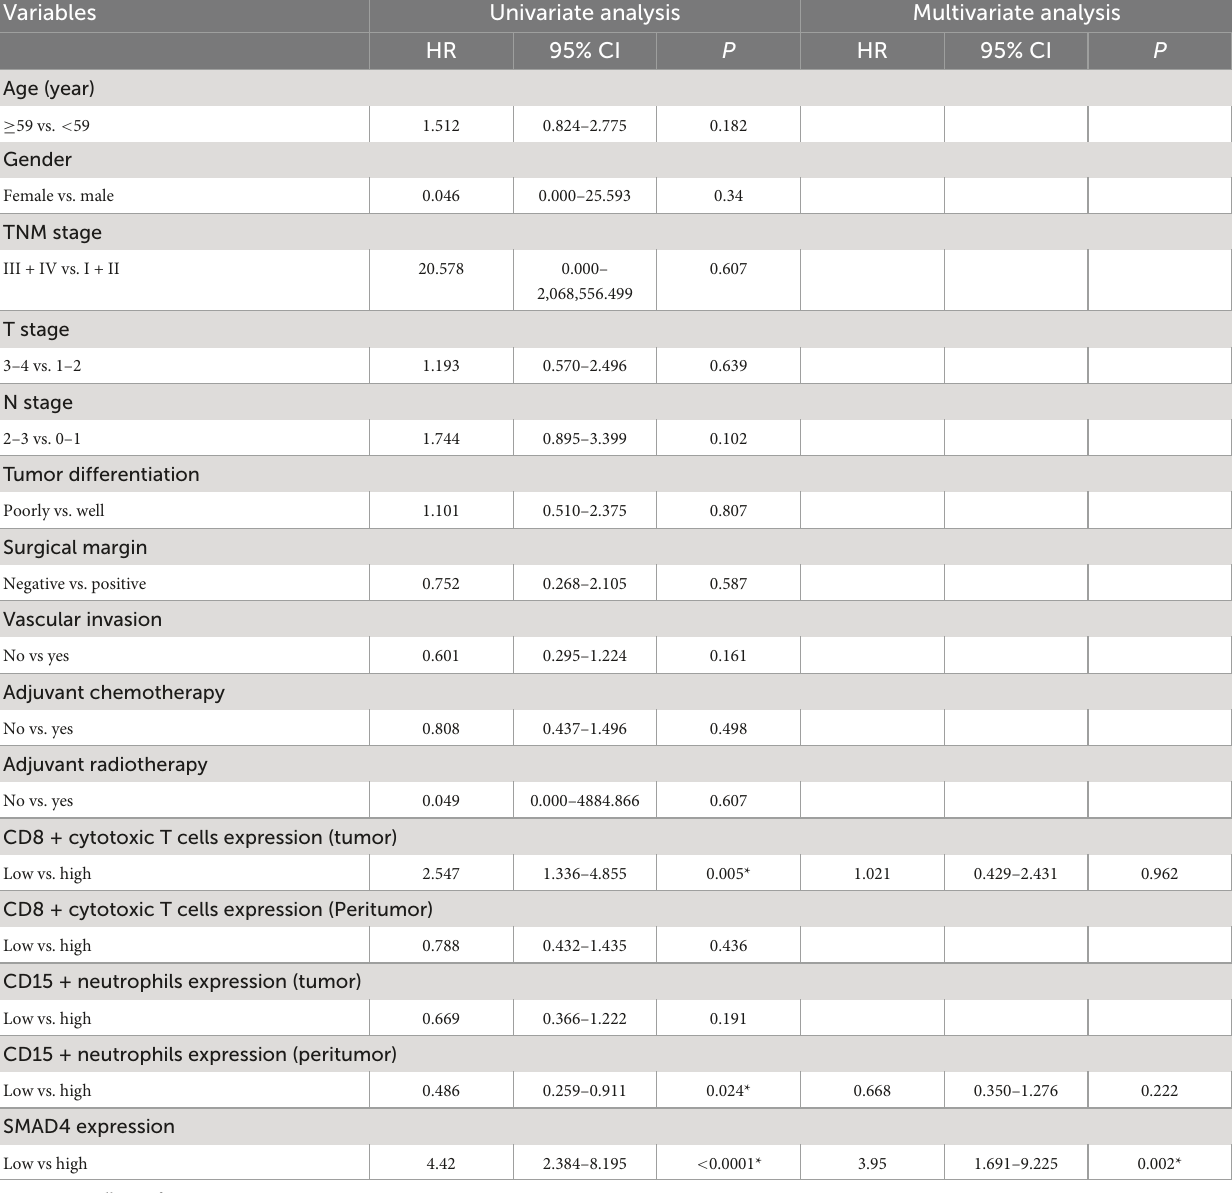
TABLE 2 Univariate and multivariate analyses of variables associated with overall survival. Variables Univariate analysis Multivariate